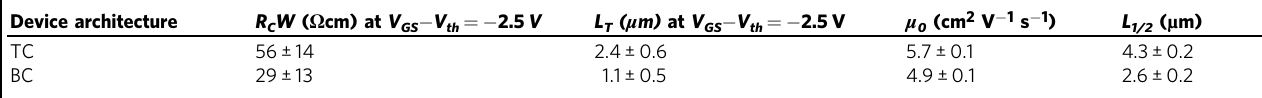
Table 1 Summary of the results of the TLM measurements performed on top-contact and bottom-contact DPh-DNTT TFTs fabricated on fl exible PEN substrates Device